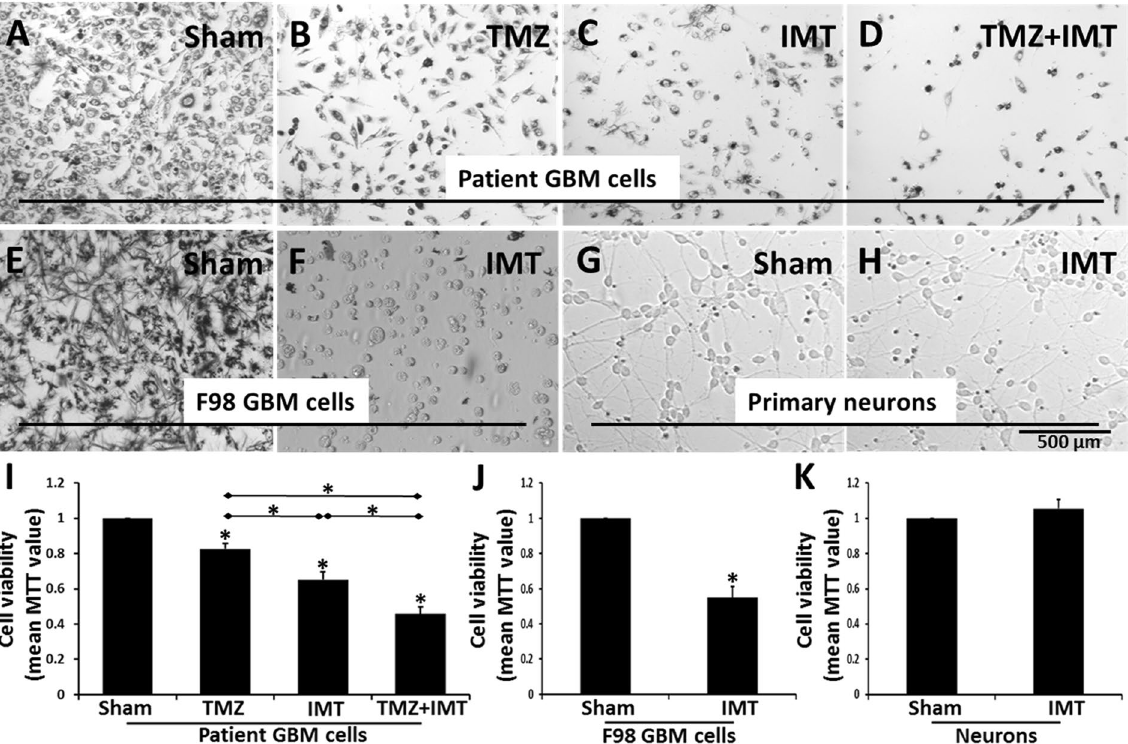
Figure 1. Impact of intermediate frequency IMT on GBM cells in vitro . Brightfield photomicrographs of patient and rodent F98 GBM cells and primary neurons are shown following a 3-day exposure to the indicated treatments. The images captured cell fields adjacent to the bioelectrode implanted within the cultures (not shown). ( A ) Patient GBM cells stained with the dark MTT chromogen demonstrate robust viability under sham conditions. A moderate reduction in staining, accompanied by pyknosis and decreased cell density was observed with ( B ) TMZ or ( C ) IMT monotherapy. ( D ) Concomitant TMZ + IMT resulted in a dramatic loss of cell viability compared to that achieved with either treatment alone. ( E , F ) Susceptibility to the same stimulation parameters was also evident in rodent F98 GBM cells as shown by MTT staining. ( G , H ) In contrast, the morphology and density of post-mitotic primary neuronal cultures, as shown here following trypan blue exposure, was not notably affected by IMT. ( I ) The viability of GBM cells from 3 different patient tumors was significantly reduced by TMZ or IMT alone. A cumulative GBM cell loss was produced by the combination of both treatments, likely reflective of distinct mechanisms of action. Asterisks directly above the data bars indicate a significant (P < 0.001) difference from the sham control. The significance (P < 0.001) between indicated data pairs is depicted by an asterisk above the horizontal lines. ( J ) F98 GBM (N = 3; P = 0.008) but not ( K ) primary post-mitotic neuronal (N = 4; P = 0.091) cultures were susceptible to IMT. Asterisks directly above the data bars indicate a significant difference from the sham control. All data are presented as mean ± standard